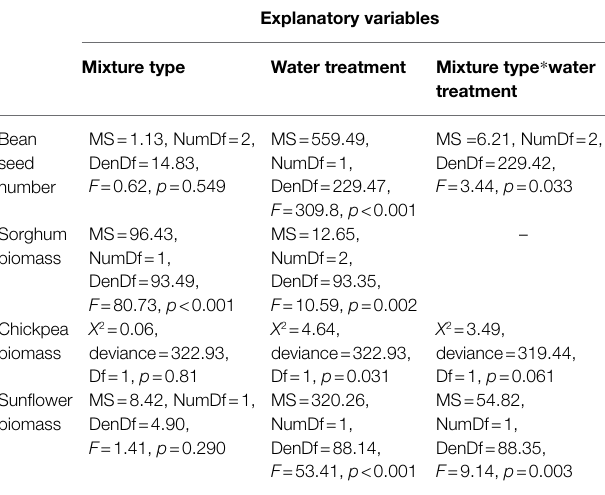
TABLE 2 | Effect of mixture type (crop mixture/bean cultivar mixture/ monoculture) and water treatment on yield (bean) and biomass (chickpeas, sorghum, and sunflower) per